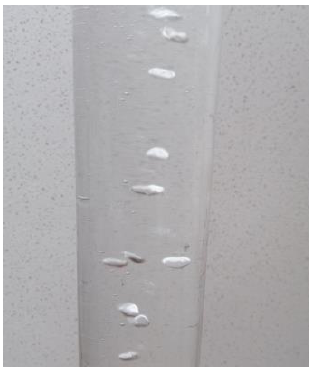
Figure 9. The instantaneous position of the bubbles.